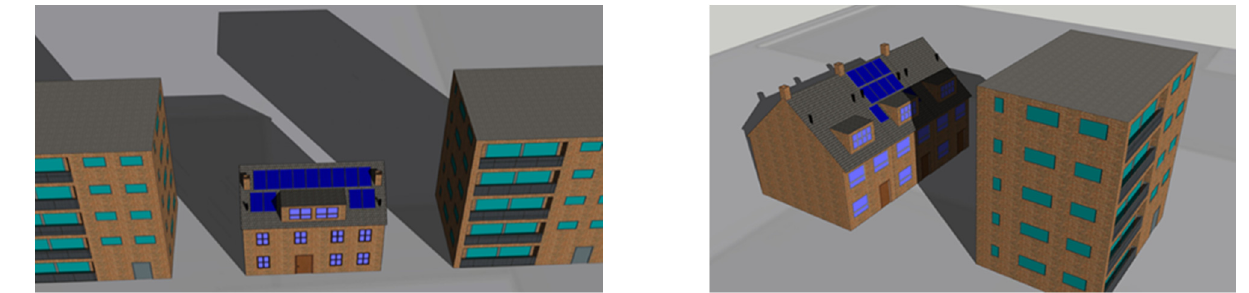
Figure 4. Representation of the two house scenarios in SketchUp, detached house on the ( left side ) and row house on the ( right side ).